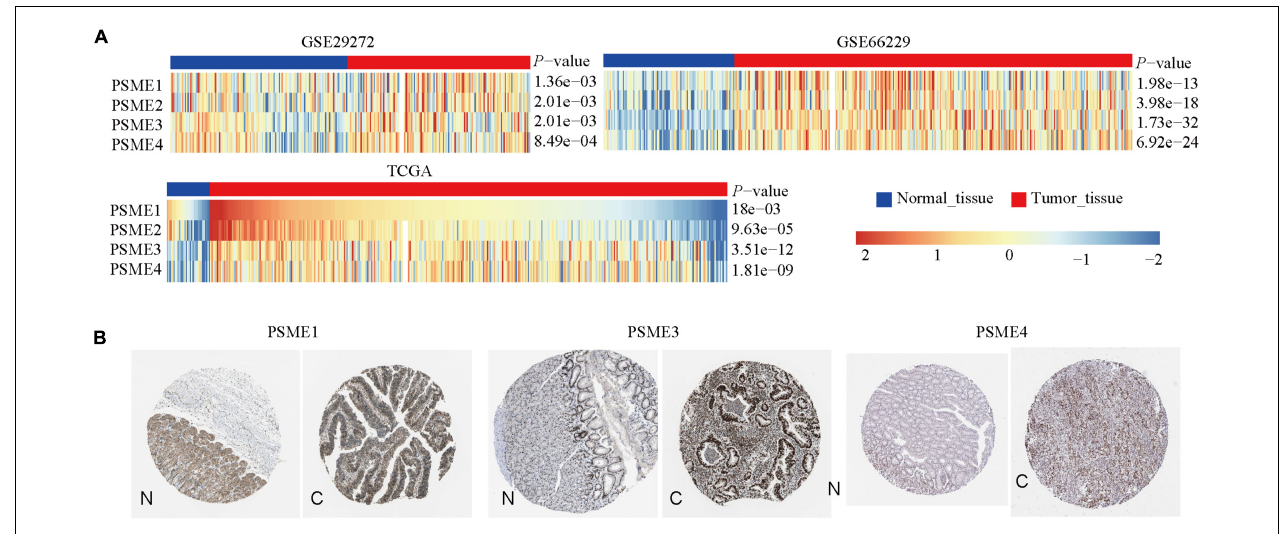
FIGURE 1 | The transcriptional and protein expression of proteasome activator subunit (PSME) family genes in patients with gastric cancer (GC). (A) High transcriptional expression of PSME family genes in GC tissues compared to normal tissues [Gene Expression Omnibus (GEO) and The Cancer Genome Atlas (TCGA)]. (B) High protein expression of PSME1, PSME3, and PSME4 were obtained in tumor tissues (The Human Protein Atlas). C, cancer; N, normal